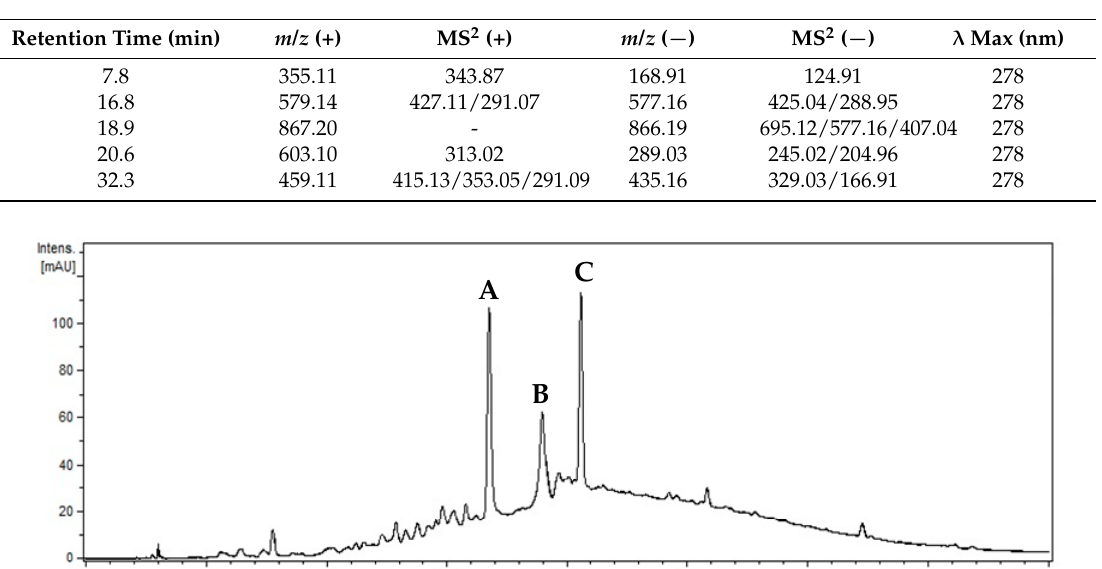
Table 2. Compounds detected in X. americana aqueous extract .